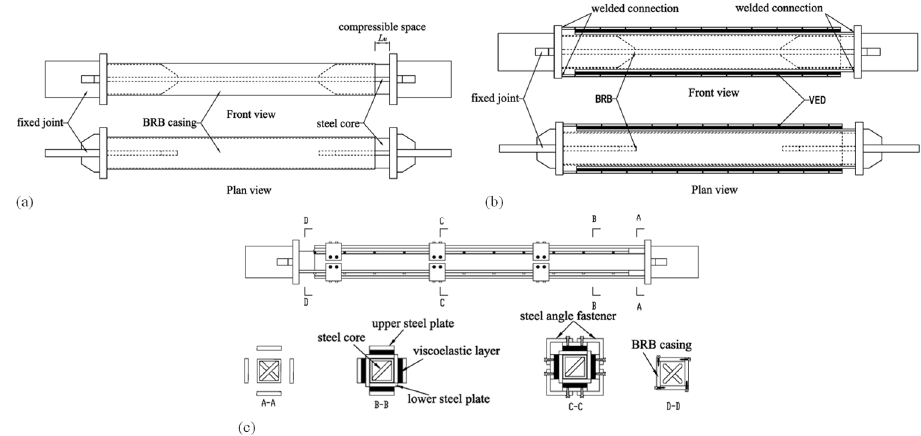
Figure 2. Configuration and assembly of VBRB specimens: ( a ) assembly of BRB; ( b ) assembly of VED; and ( c ) schematic and sectional drawing of VBRB specimen.